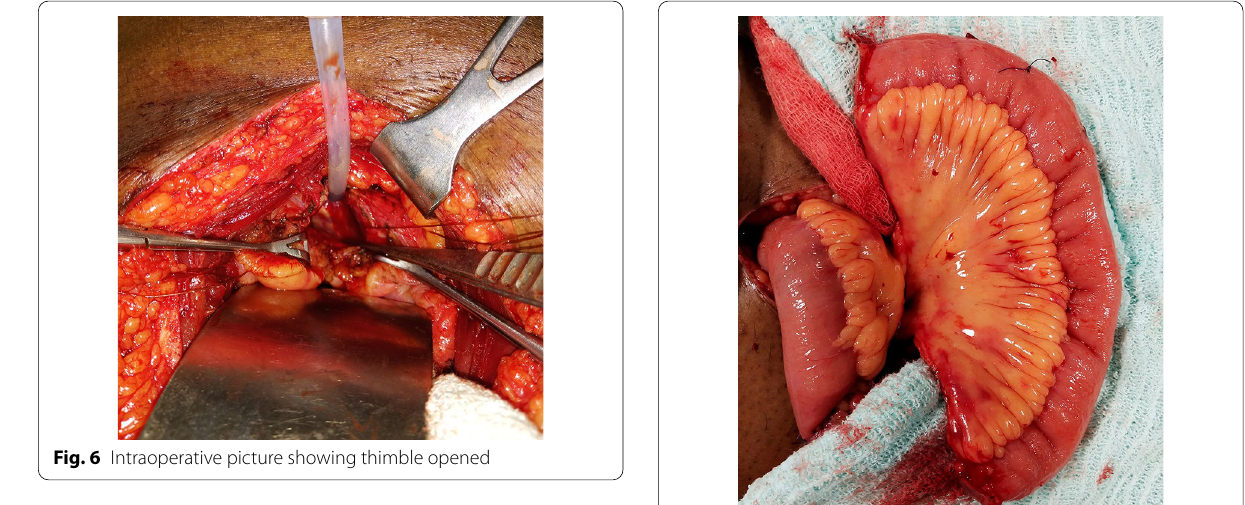
Fig. 9 Augmentation using ileum